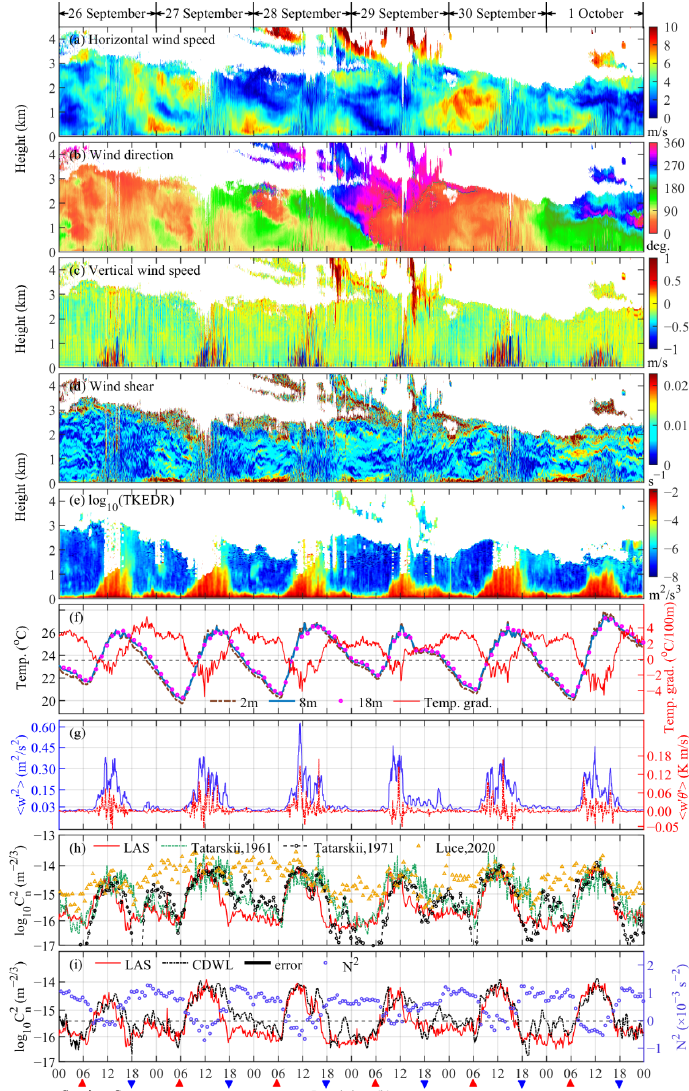
Figure 2. The horizontal wind speed ( a ), wind direction ( b ), vertical wind speed ( c ), wind shear ( d ), log 10 (TKEDR) ( e ), temperature and its gradient ( f ), variances in vertical wind fluctuation and flux of potential temperature ( g ), log 10 C 2 n estimated by different methods ( h ), Brunt–Väisälä frequency squared, log 10 C 2 n and its shaded area error bar ( i ) retrieved from CDWL, wind tower, and LAS in